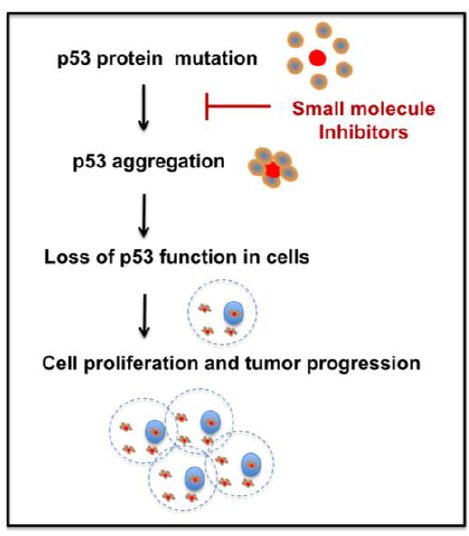
Figure 2. Schematic of the p53 mutant aggregation inhibition approach for treating cancer.